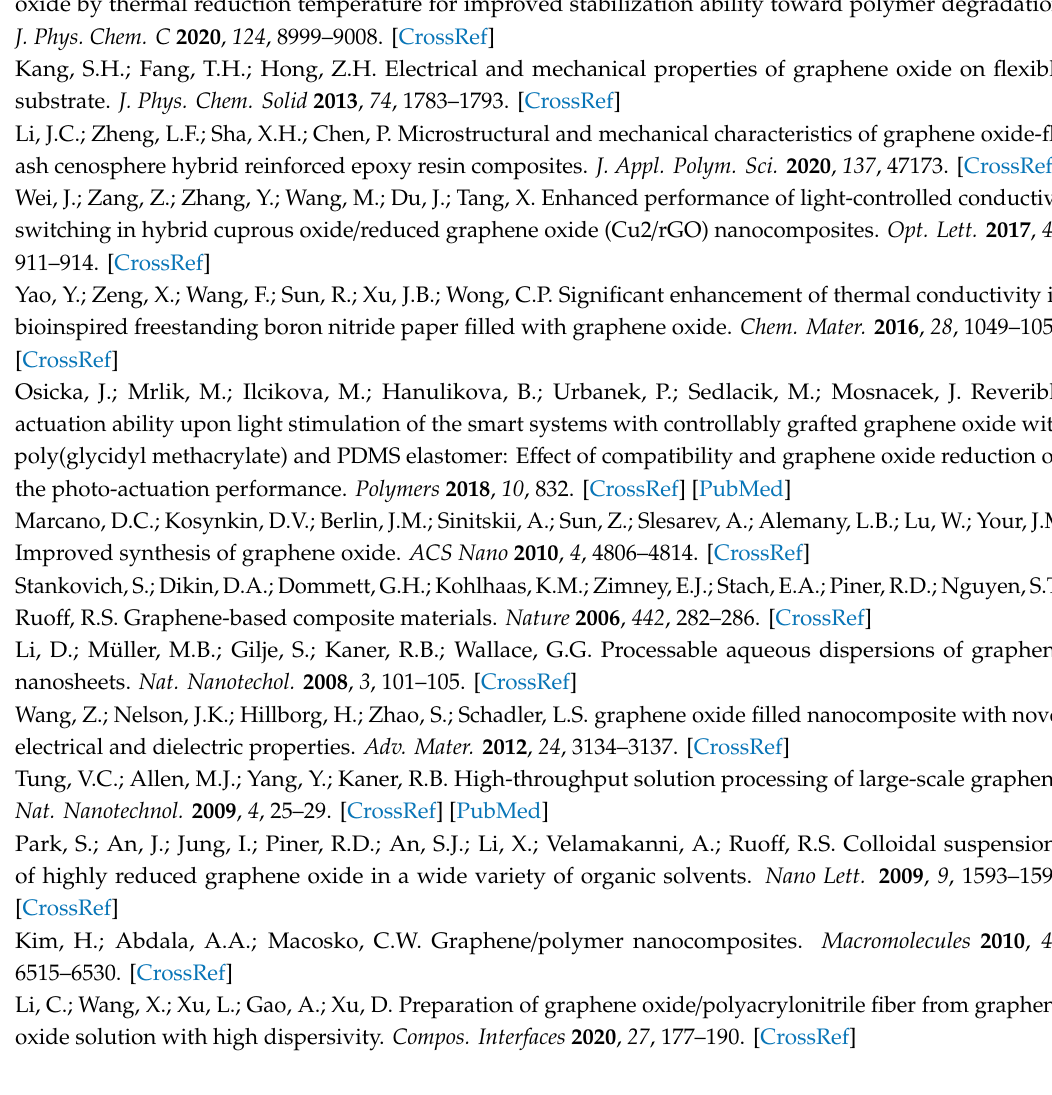
Figure S1: Raman spectra of GO, mGO, mRGO1 and mRGO2, Figure S2: XRD patterns of GO, mGO, mRGO1 and mRGO2, Figure S3: SEM images of (a) GO, (b) rGO, (c) mGO, and (d) mRGO2, Figure S4: Relationship between absorbance ratio and styrene contents of styrene-acrylonitrile